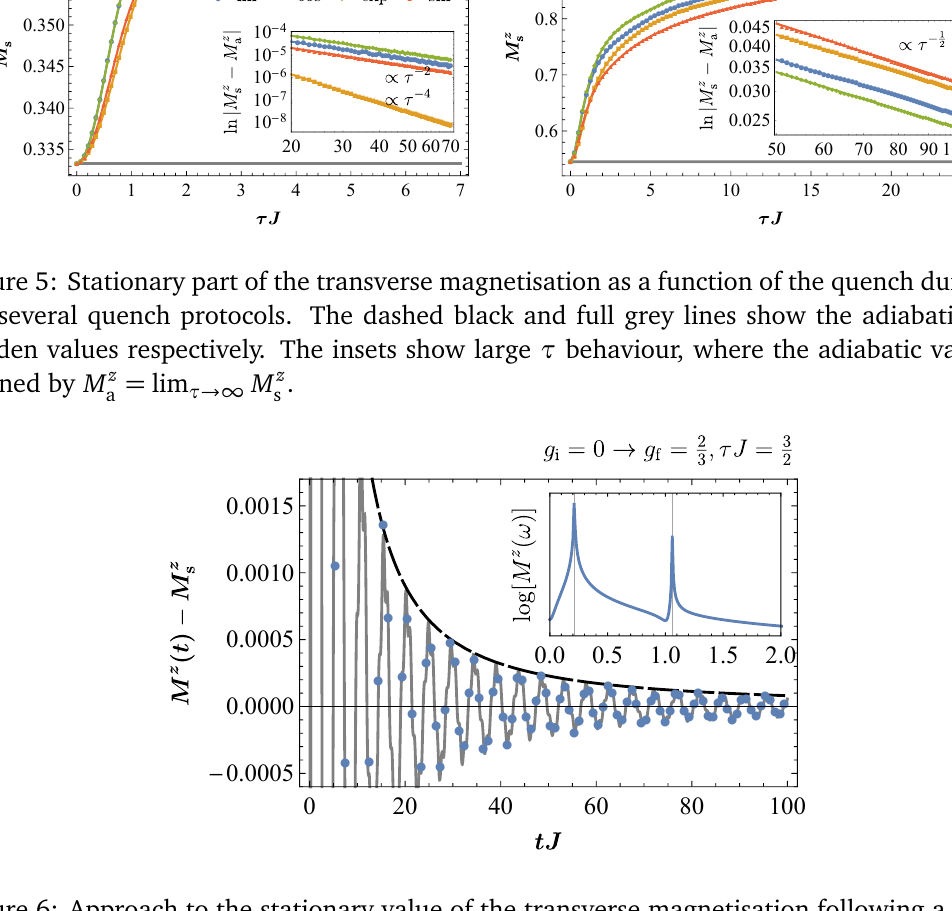
Figure 6: Approach to the stationary value of the transverse magnetisation following a linear quench. The full grey line is the stationary phase approximation result, the dashed line is t − 3 / 2 with a constant prefactor, and the blue dots show the numerical evaluation for certain times. 2 ω and 2 ω π indicated by the vertical 0